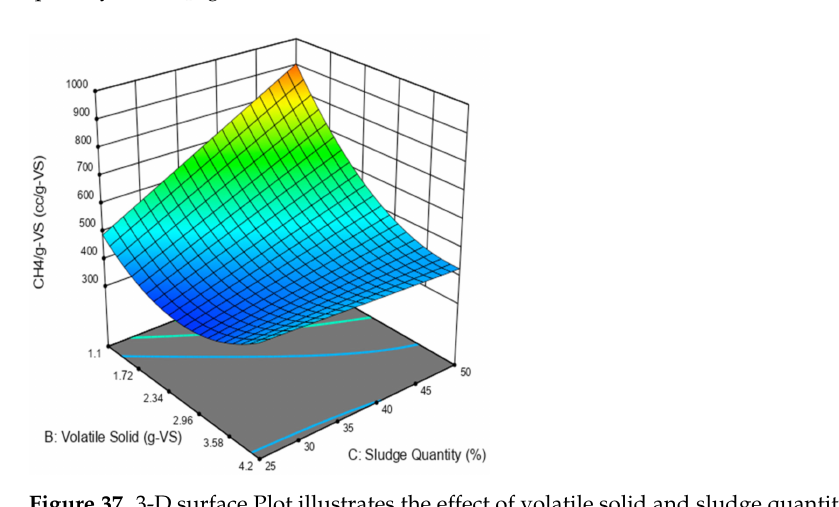
Figure 36. Interaction Plot illustrates the effect of interaction between volatile solid and sludge quantity on CH 4 /g-VS.